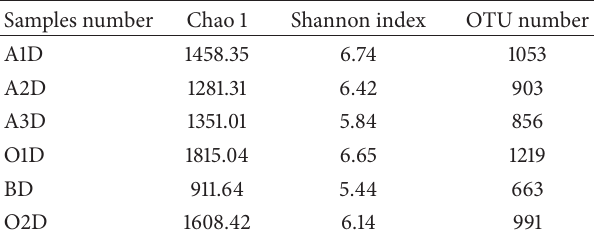
Table 5: Microbial community diversity in the sludge sample of the reactor.